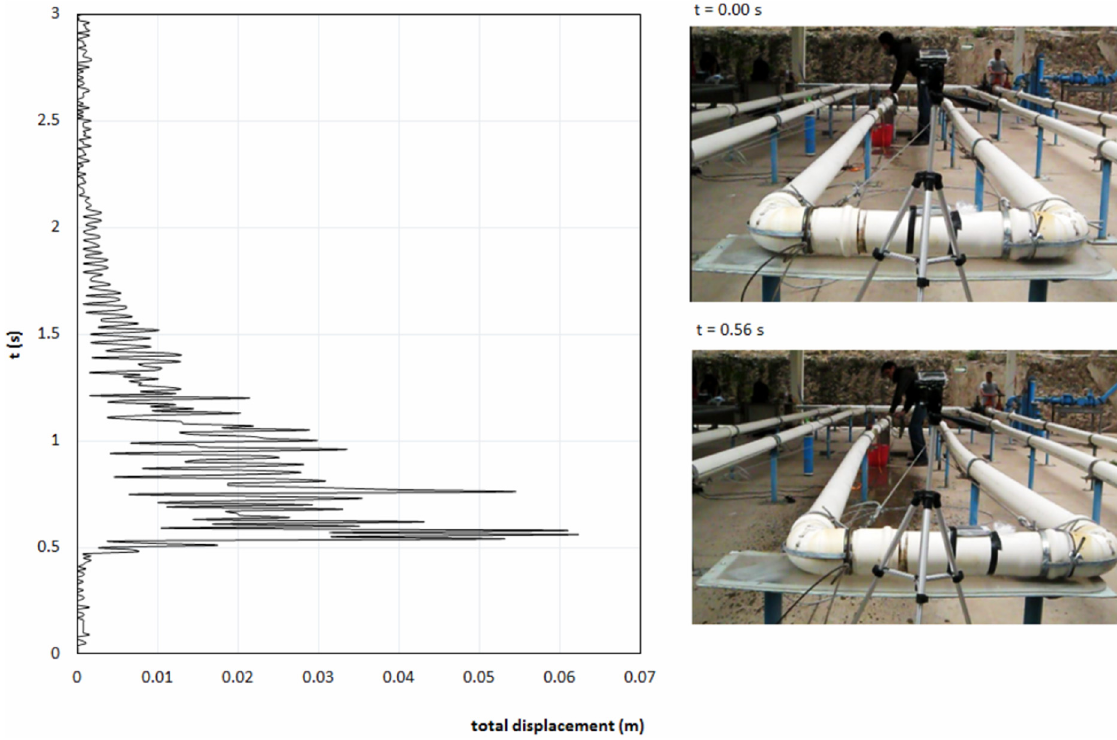
Figure 4. Pipe displacements over